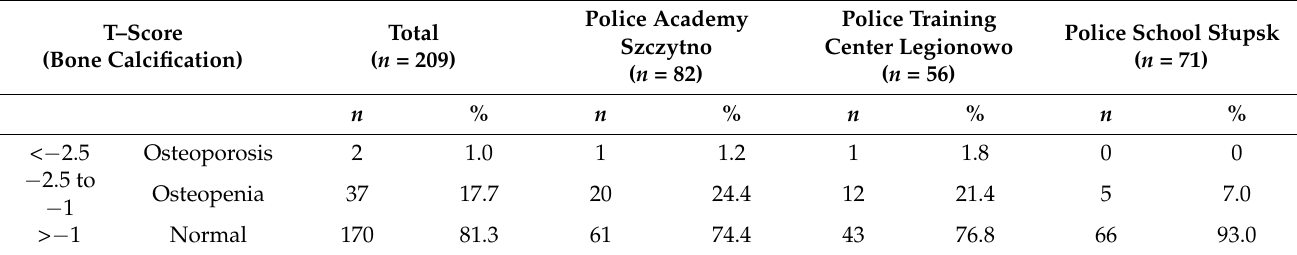
Table 6. Assessment of the bone calcification of male police officers ( n =